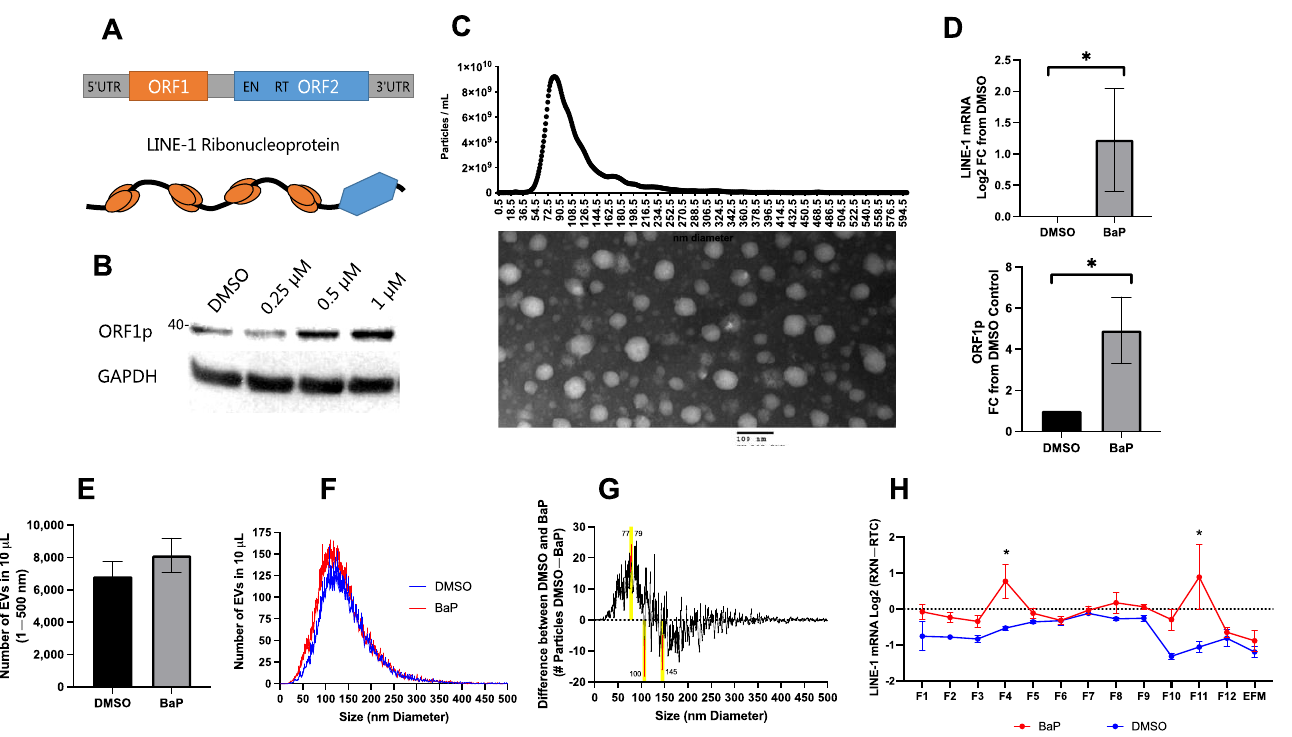
Figure 1. Long Interspersed Element-1 (LINE-1) induction by benzo[a]pyrene and its impact on extracellular vesicle (EV) LINE-1 content, number, and size. ( A ) LINE-1 element domain structure. LINE-1 is a 6 kb repetitive DNA element that comprises 5′ and 3′ untranslated regions (UTRs) and two proteins, ORF1p and ORF2p. ORF1p is a 40 kDa nucleic acid binding protein that forms multimers. ORF2p is 150 kDa and contains both endonuclease (EN) and reverse transcriptase (RT) domains. ORF1p trimers and ORF2p exhibit strong affinity for the LINE-1 mRNA, and together form a ribonucleoprotein (RNP) containing both the template and enzymatic machinery required for target-site primed reverse transcription. ( B ) ORF1p induction in H460 cells by benzo[a]pyrene (BaP). To examine LINE-1 content in EVs, we used a LINE-1 inducer, the carcinogen BaP. ( C ) EV preparation. EVs were collected from cells challenged with 1 μM BaP for 48 h. The size and morphology of the preparation was assessed using Nanosight Nanoparticle Tracking Analysis (NTA) (top) and electron microscopy (bottom). ( D ) H460 EV LINE-1 content. BaP exposure increased EV LINE-1 mRNA and ORF1p content in BaP treatments compared to DMSO controls (as measured by One-Step RT-qPCR and ELISA; * p < 0.05; Welch’s t -test) but did not significantly alter the total abundance of EVs ( p > 0.05; t -test), as shown in ( E ). NTA of BaP and DMSO treatments ( F ). ( G ) BaP-induced size differences. To examine subtle changes in EV size, total EV numbers were normalized to 5000 particles per reading, and each EV size bin was compared between treatments using a two-way ANOVA. Yellow bars indicated EV sizes with significant differences. N = 3 – 5. ( H ) Test gradient (BaP vs. DMSO control). For subsequent density gradient EV studies in this cell line, we performed a test gradient and determined that BaP exposure (red) was necessary to raise LINE-1 expression to detectable levels. * Difference between DMSO and BaP ( p < 0.05; two-way ANOVA).